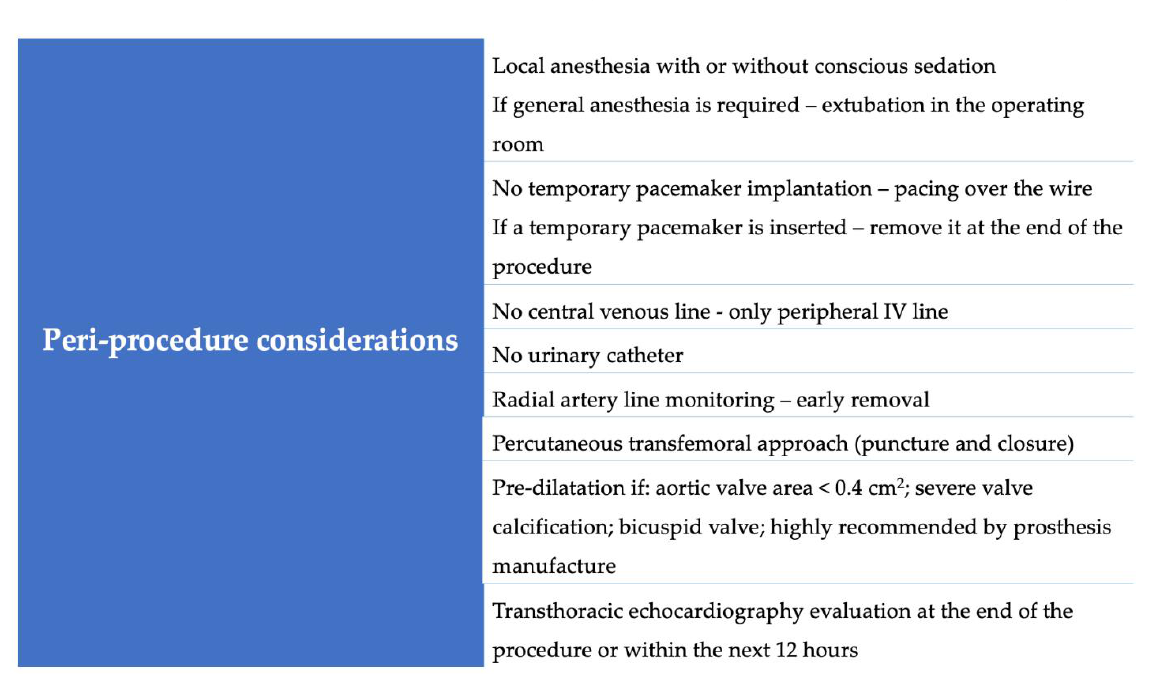
Figure 4. Minimalist TAVI peri-procedure considerations.